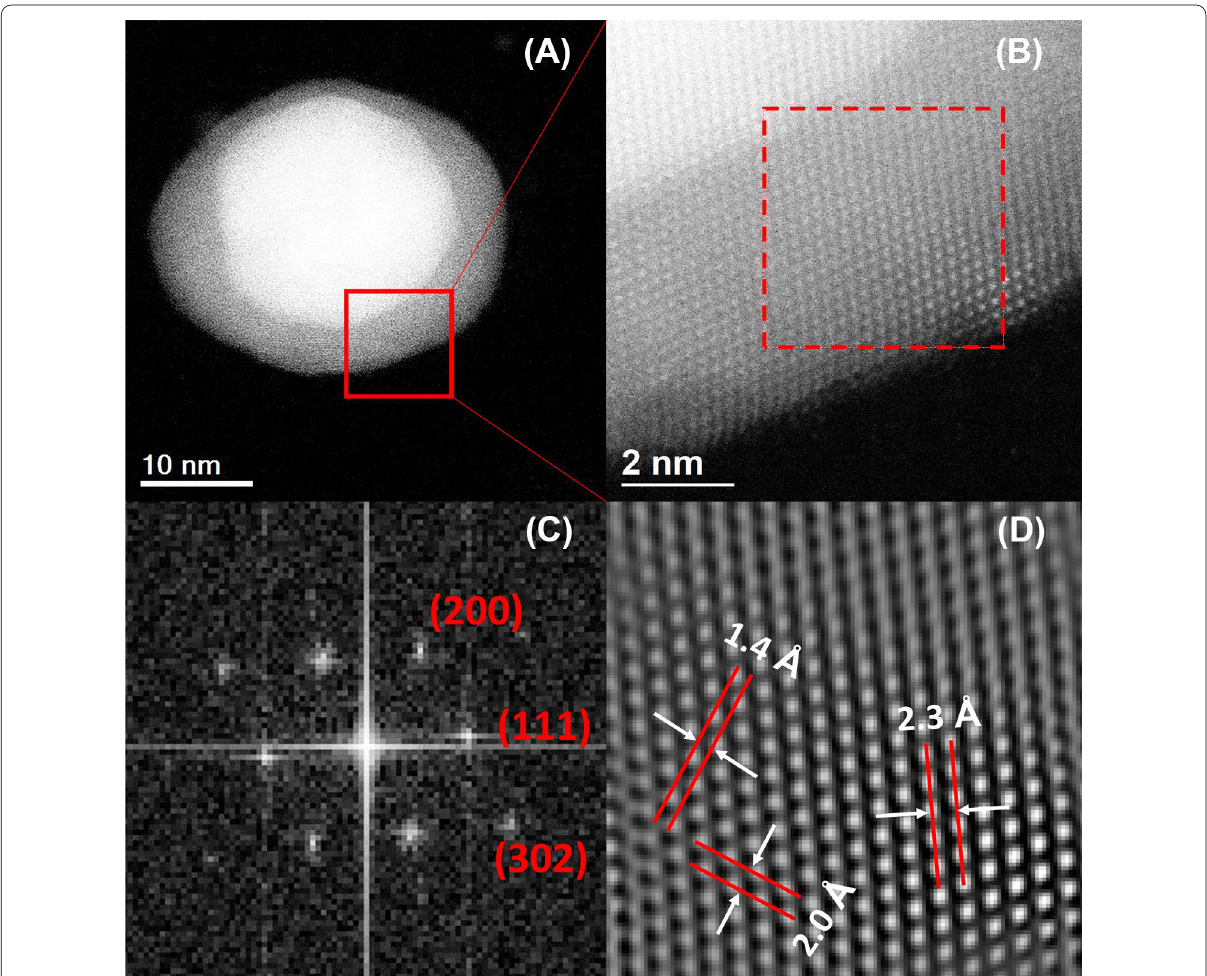
Fig. 5 Au@AgNPs HRTEM ( a ). Magnification from ( a ) of interface core–shell ( b ). FFT plot with Miller index ( c ) and integrated image from FFT (Inverse) with interplanar distance ( d